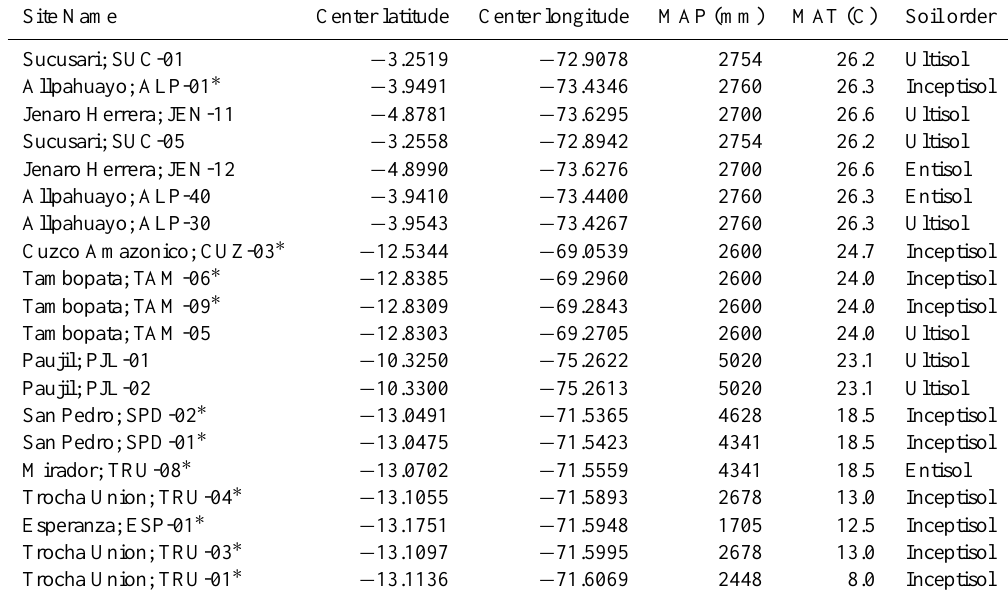
Table 1. Description of 25ha landscapes mapped and analyzed in the Andes-to-Amazon corridor. Soil orders follow the US Department of Agriculture (USDA) soil taxonomy system. Sites labeled with an asterisk ( ∗ ) are those considered to be higher in soil fertility, as reported in the literature.